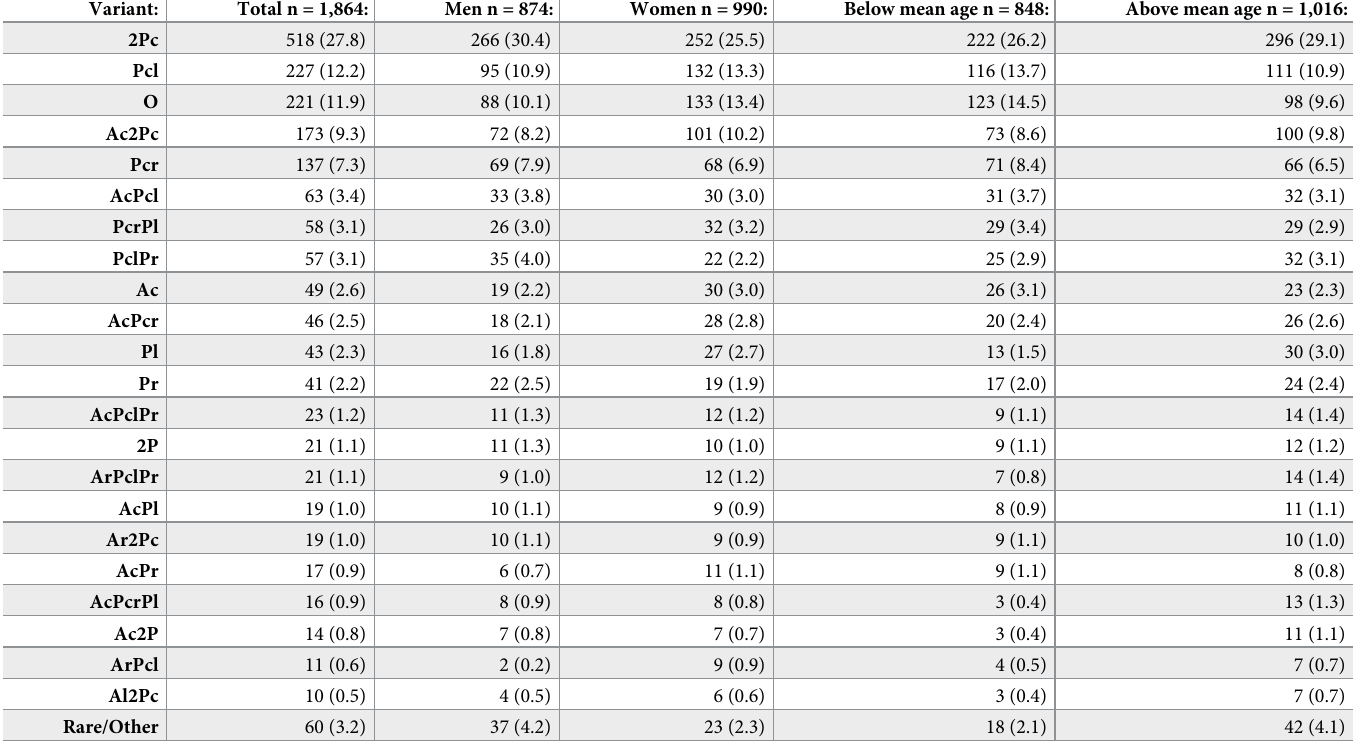
Table 2. Frequencies of common Circle of Willis variants for the whole sample, and their frequencies for men and women, and for being below and above mean age [number of cases (percentage of column total)].